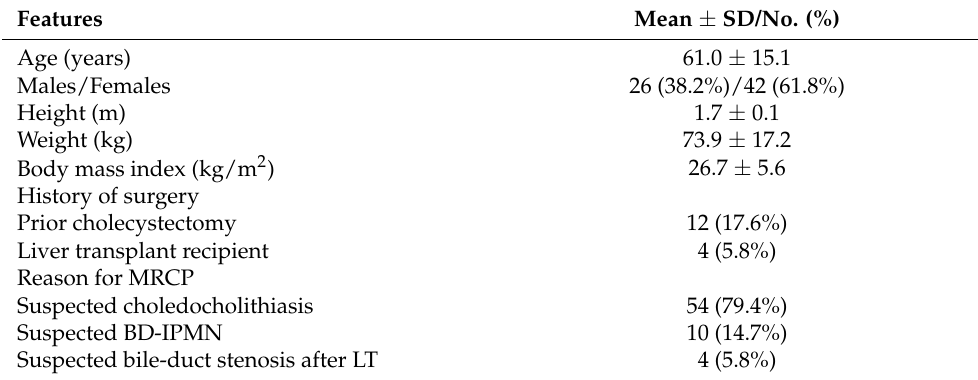
Table 4. Main features of the 68 study patients.